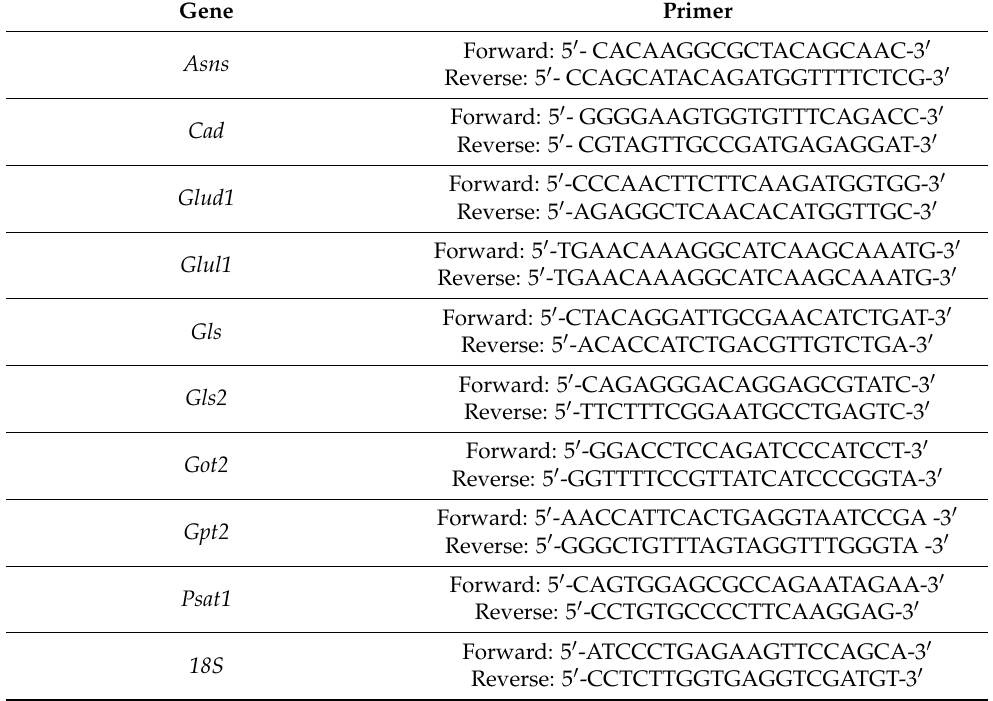
Table 1. Primers used for